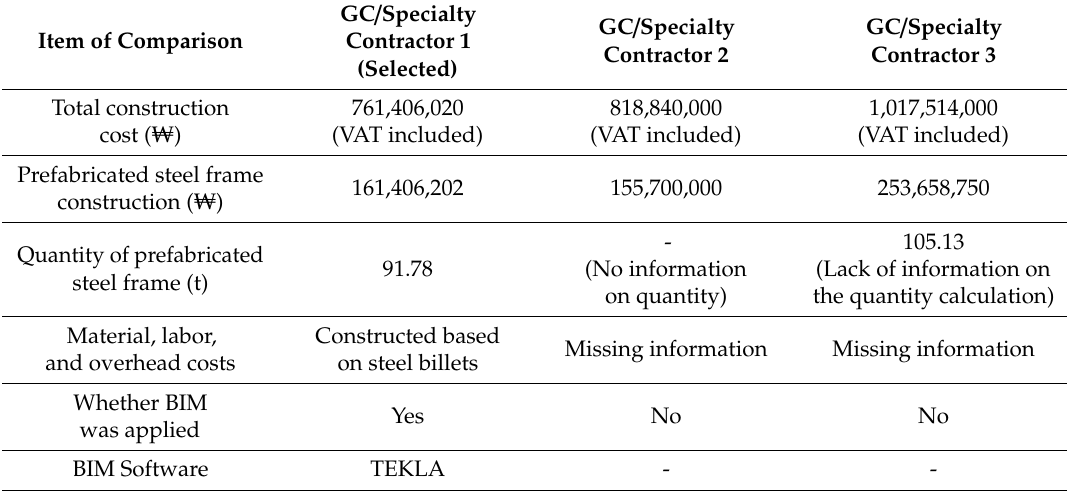
Table 7. Comparative analysis for general contractor / specialty contractor (GC / SC) who participated in the case study project